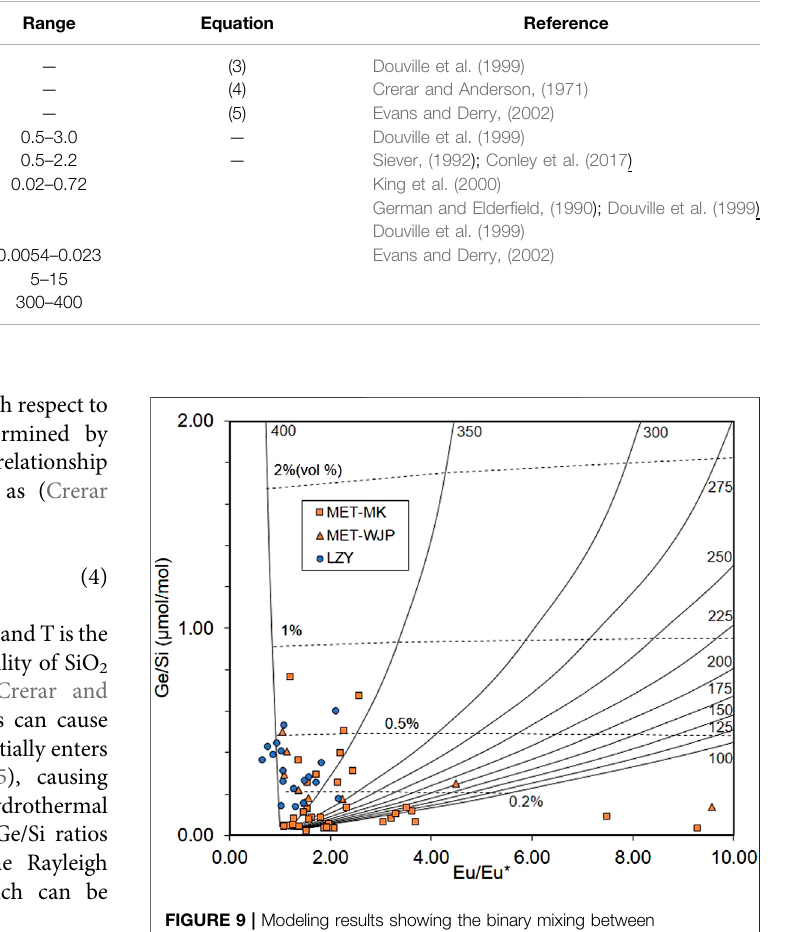
FIGURE 9 | Modeling results showing the binary mixing between hydrothermal fl uid and seawater. The solid contour lines represent hydrothermal fl uids of different temperatures (100 – 400 ° C), while the tick marks and the dashed lines indicate the volume fraction of hydrothermal fl uid (0.2% –